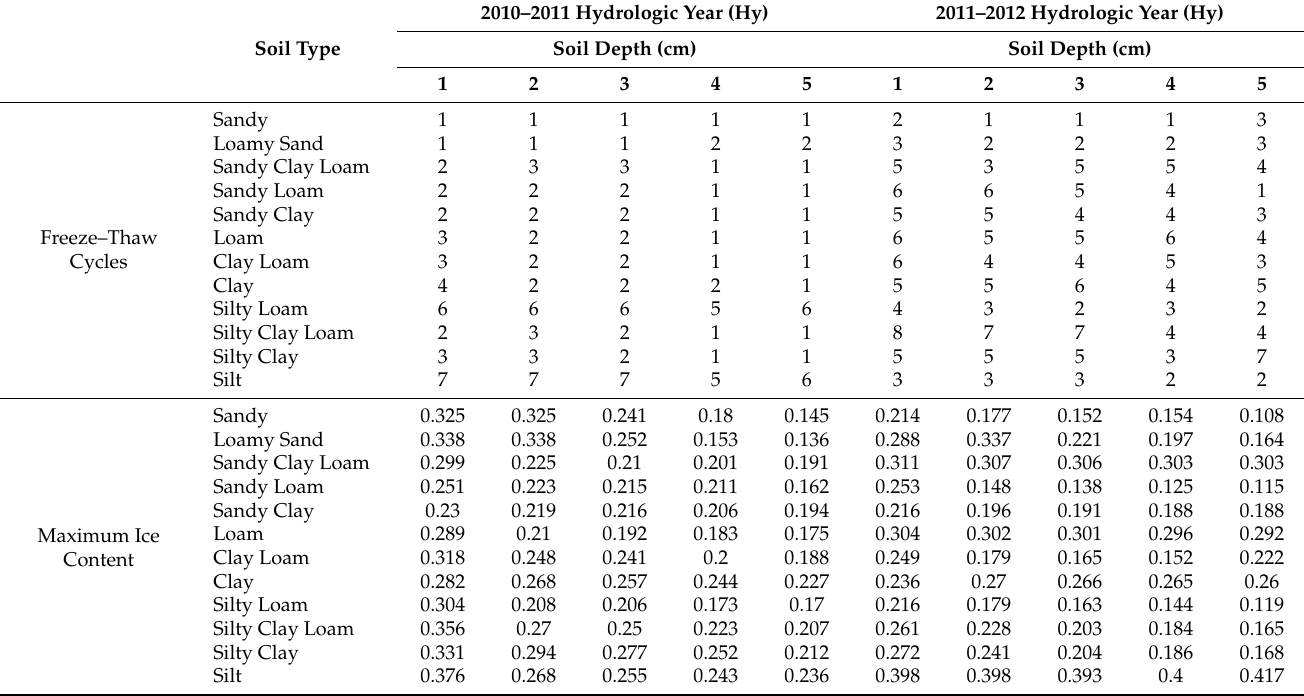
Table 3. Freeze and thaw cycles within first 5 cm depth (first five soil nodes) and maximum ice content in both hydrologic years (Hy)